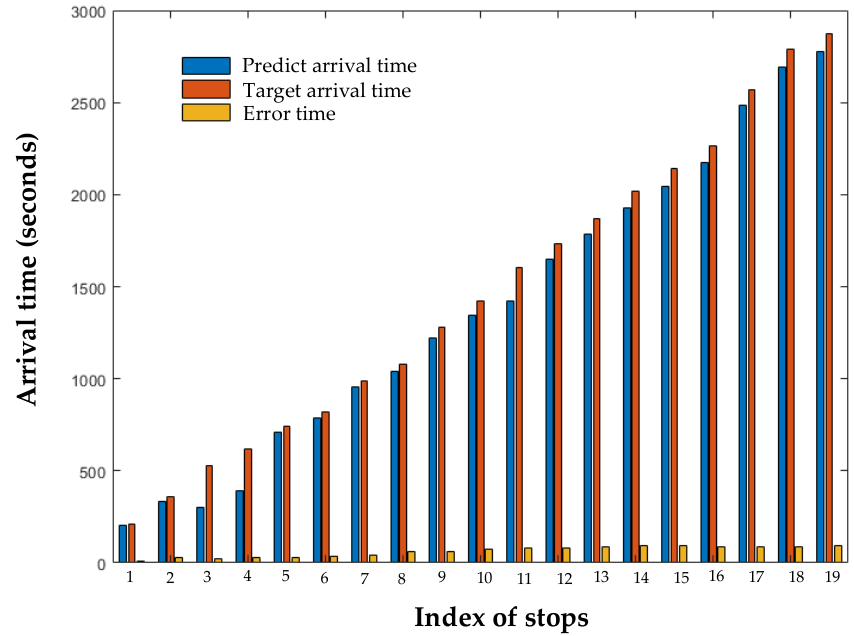
Figure 8. Actual / predicted arrival time and cumulative error diagram for each Figure 8. Actual/predicted arrival time and cumulative error diagram for each site.